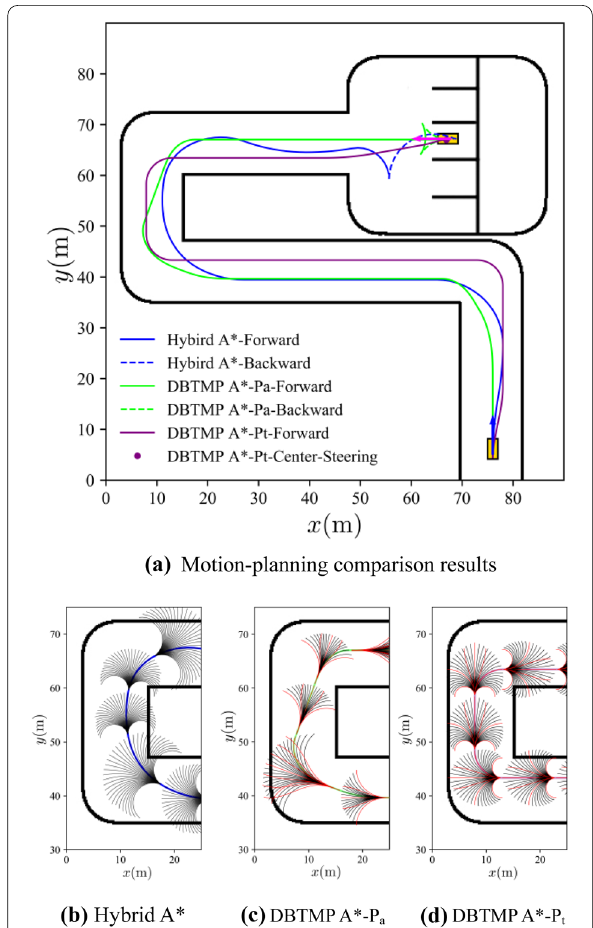
Figure 11 Comparison of motion-planning results in low-speed scenes: ( a ) Comparison of the three motion-planning algorithms under the same initial and final state conditions (The blue and purple arrows indicate the position and heading of the initial and end conditions separately), ( b )–( d ) Details of the MP extension of the three motion-planning methods (The final selected single MP in the MP cluster is represented by a thick solid line)